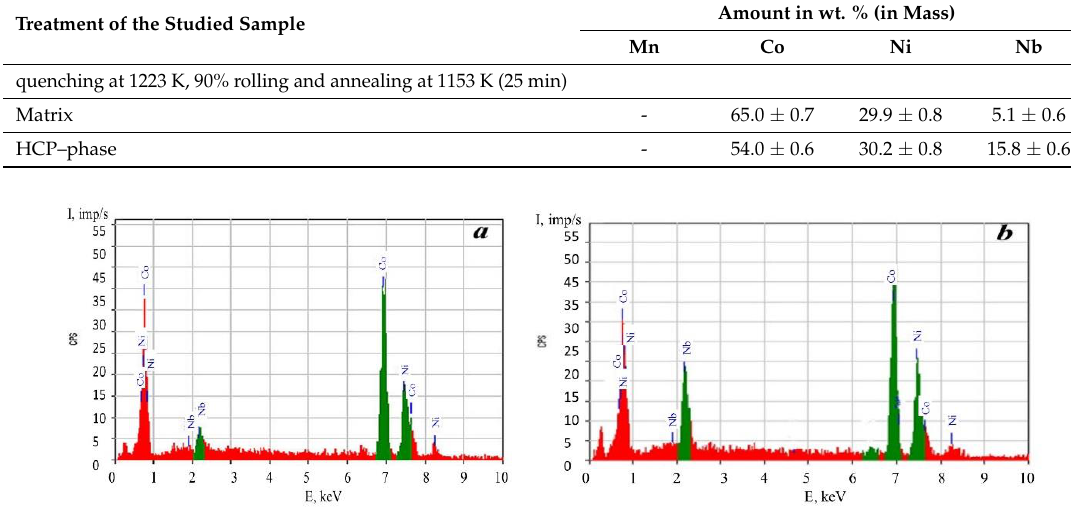
Table 2. Data on the elements composition of the samples of the Co-Ni-Nb alloy obtained on the electron microscope with the microanalyzer.